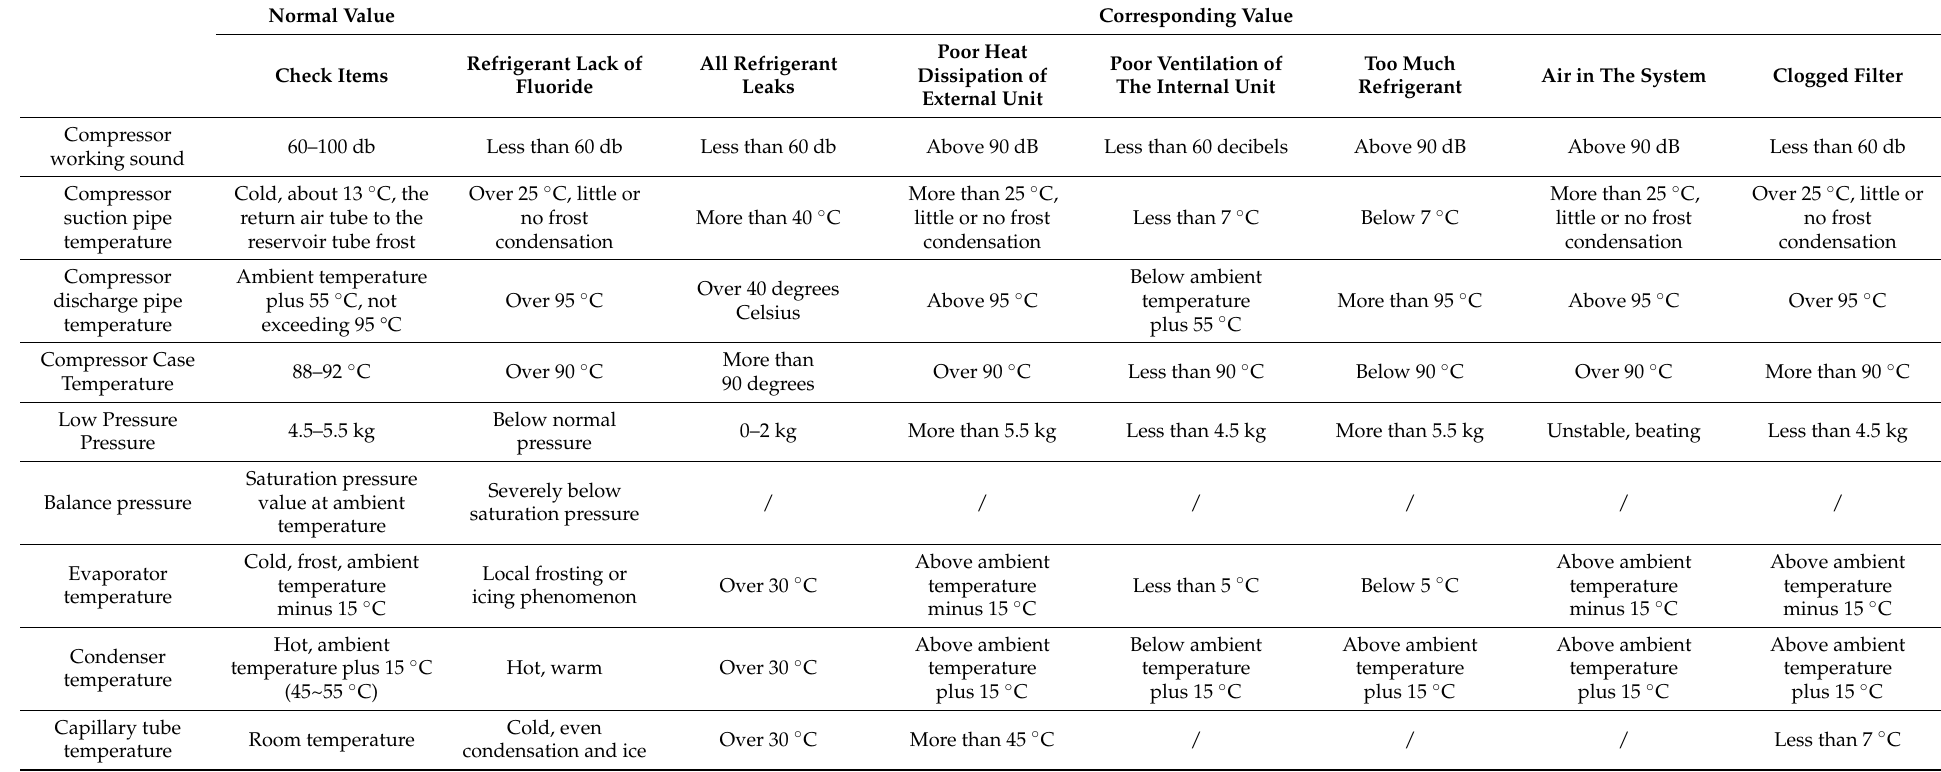
Table 4. Monitoring model based on 12 million O&M data analysis and mining of precision air conditioning failure